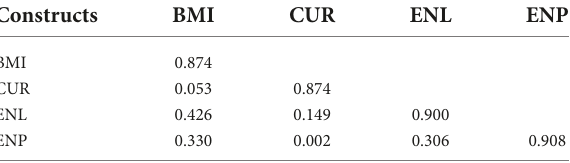
TABLE 4 Discriminant validity (Fornell-Larcker criterion).